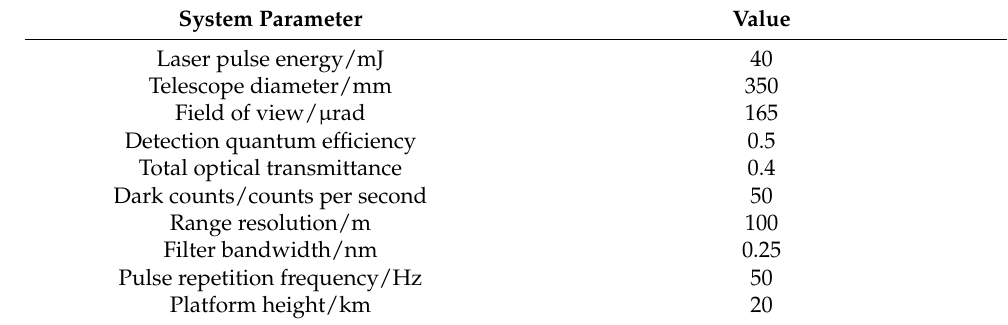
Table 1. Simulation parameters of lidar system.